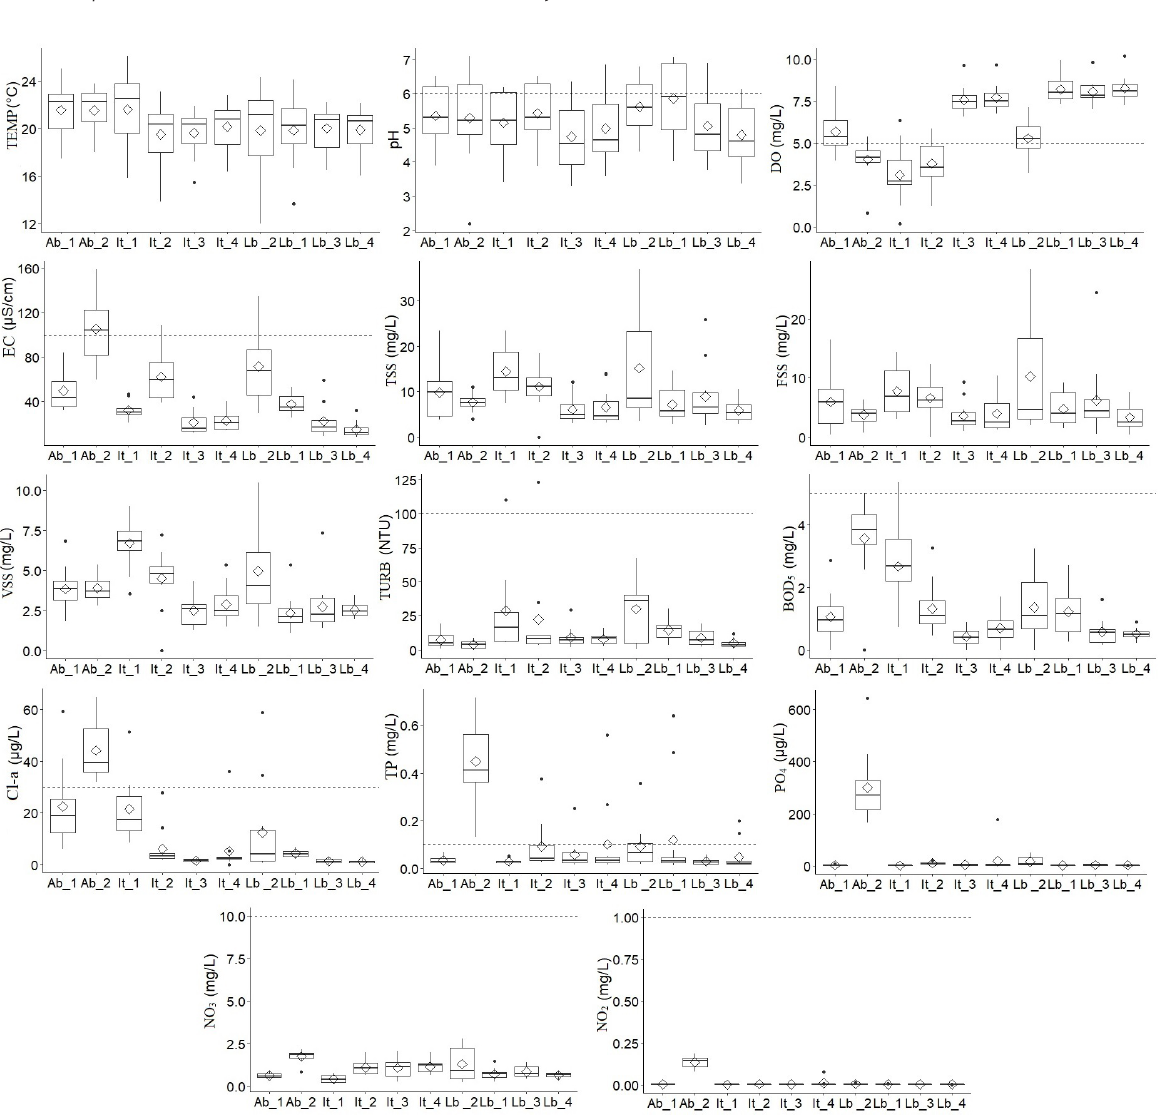
Figure 3. Boxplot graphs of the quality parameters obtained at the monitoring